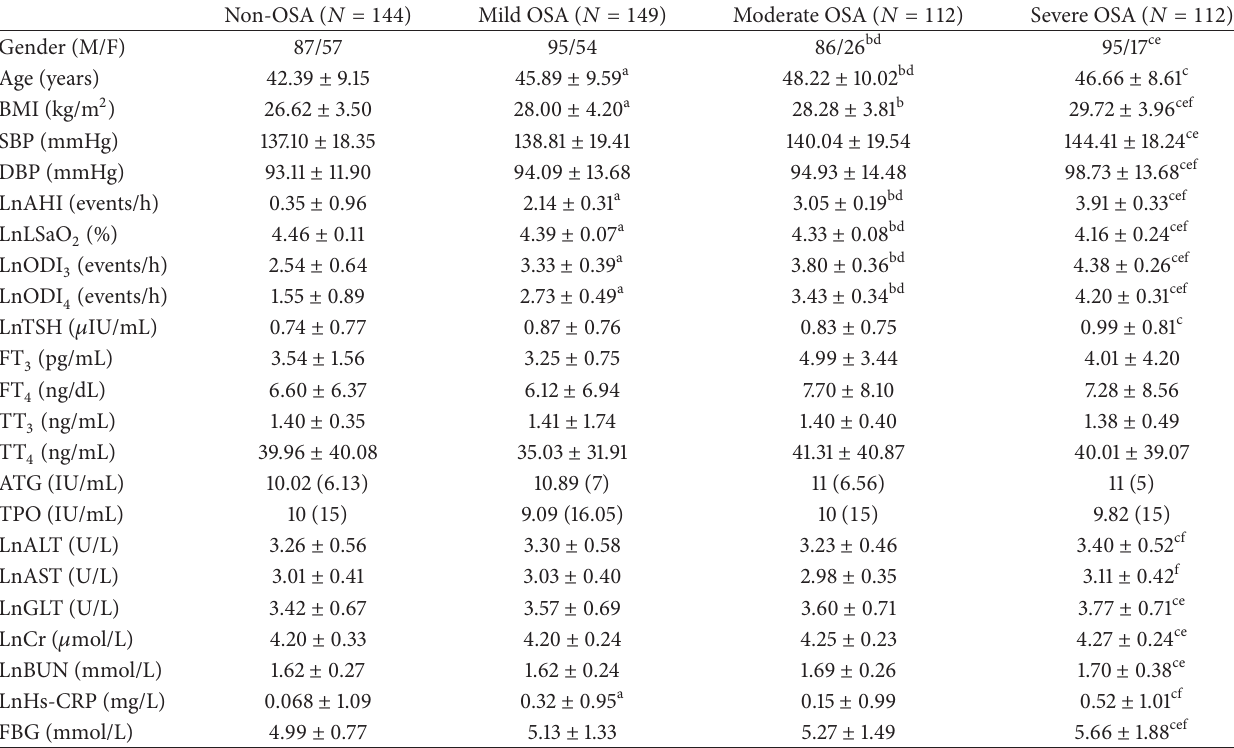
Table 1: Comparison of demographic characteristics and polysomnographic and biochemical parameters between non-OSA and mild to severe OSA subjects.